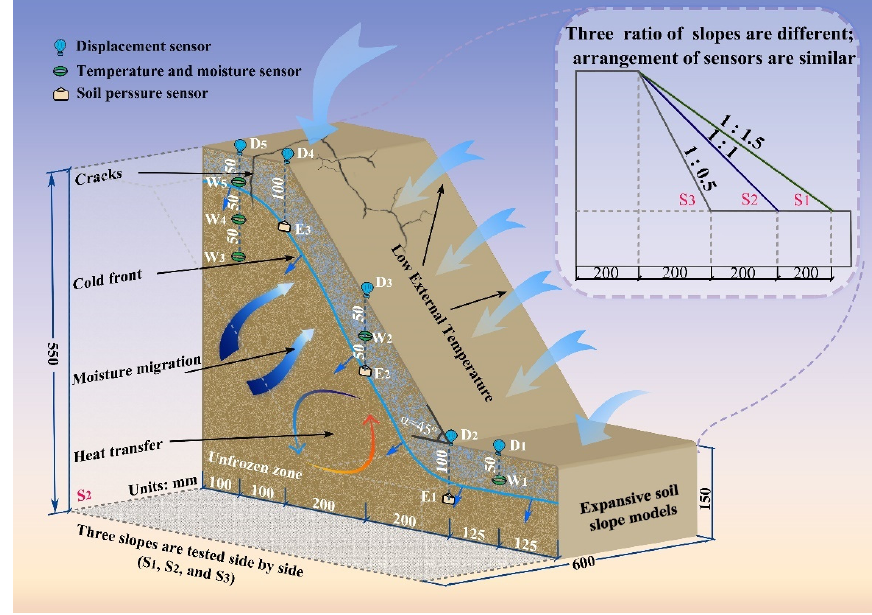
Figure 3. Slope freezing model and freeze–thaw monitoring system.